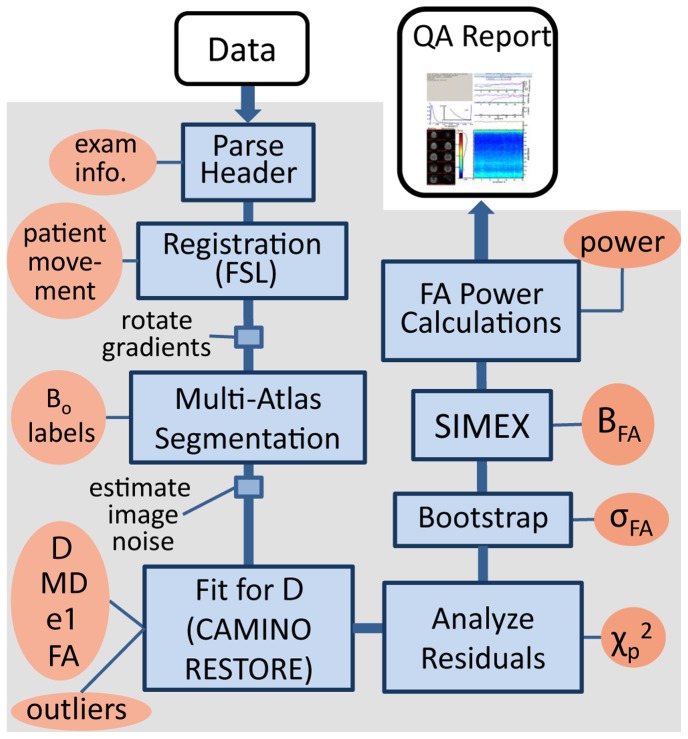
Flowchart of QA pipeline showing major processing steps (blue boxes) and outputs stored or graphed in the QA report (red ovals).Not shown is conversion of image data to NIfTI files (immediately after ‘Parse Header’), the creation of two brain masks after ‘rotate gradients’, one mask for CAMINO and a second slightly more restrictive mask for statistical analysis, and the implied additional calculation of  in ‘Analyze Residuals’.